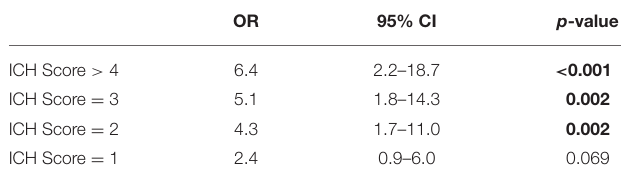
TABLE 2 | Risk for infectious complications for each point increase of the ICH Score.